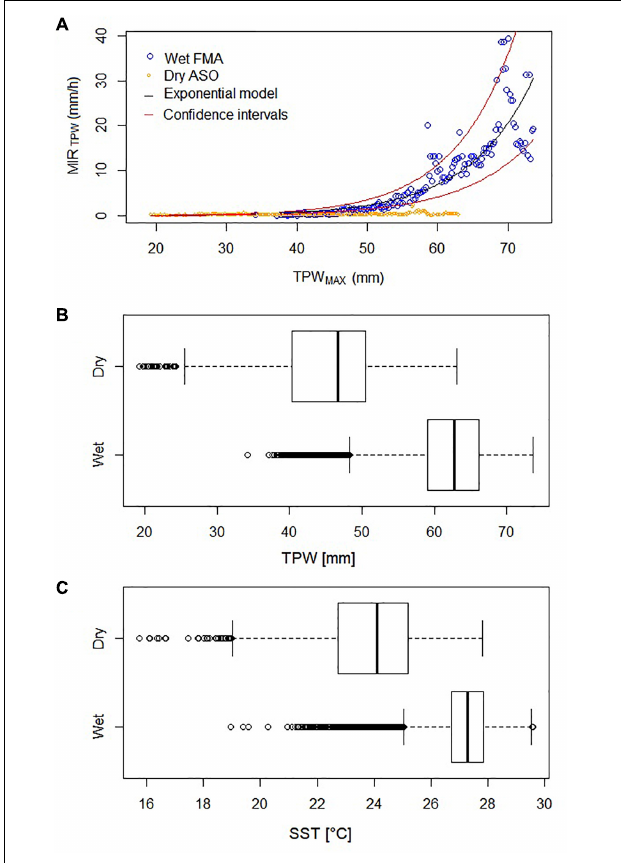
FIGURE 5 | (A) MRI values for the wet and dry seasons, separately, associated with the TPW values. The adjusted exponential model and its confidence intervals are presented; (B) TPW values of the Dry and Wet season; (C) SST values registered in the Dry and Wet